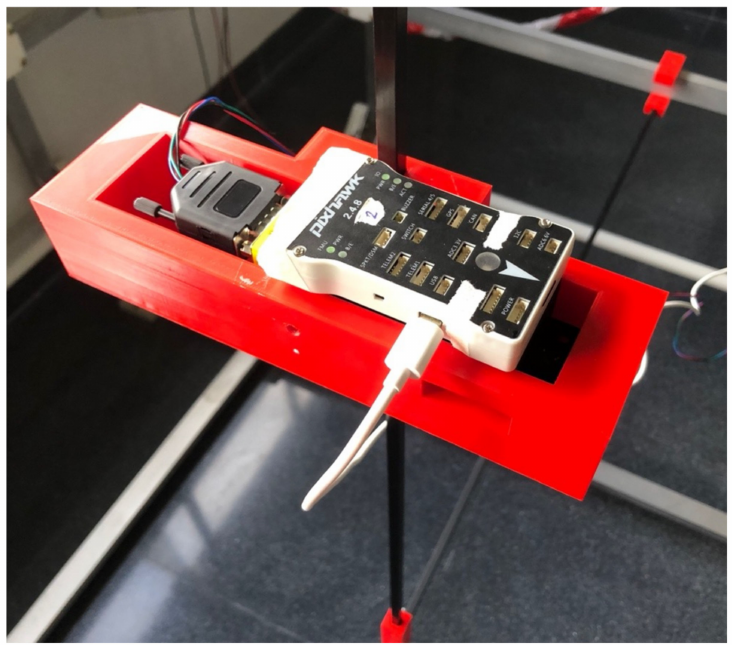
Figure 5. Pixhawk and HMR2300 gaussmeter placed in a 3D printed cage in the Helmholtz-based testing